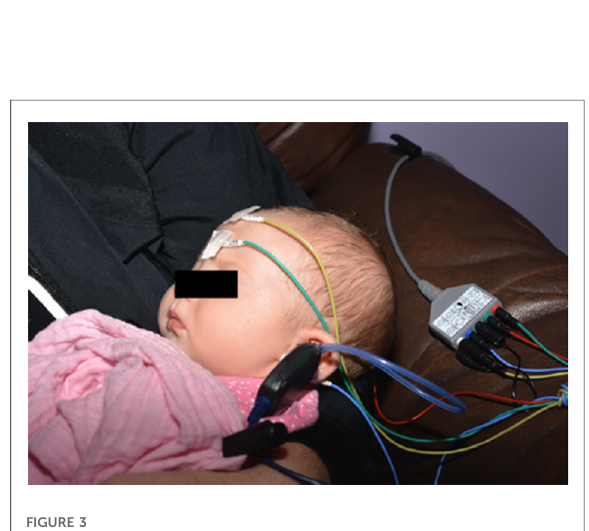
FIGURE 3 Infant undergoing unsedated (natural sleep) auditory brain stem testing